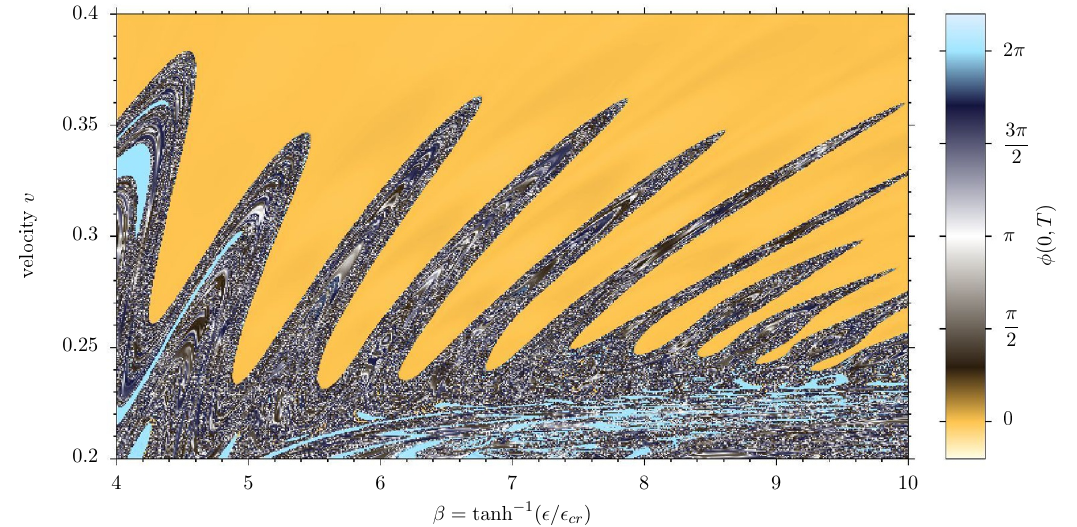
Figure 21 . The near-critical region of figure 20. The range 4 . . . 10 of the horizontal parameter β = tanh − 1 ( (cid:15)/(cid:15) cr ) corresponds to (cid:15) running from 2 . 608195 to 2 . 609946 . For these near-critical values of (cid:15) the antikink and kink have increased widths, and so for this plot they were placed further apart at t = 0 , at x = − 40 and x = 40 . The dangers of placing the initial kinks and antikinks too close together can be seen by examining figure 29 below.